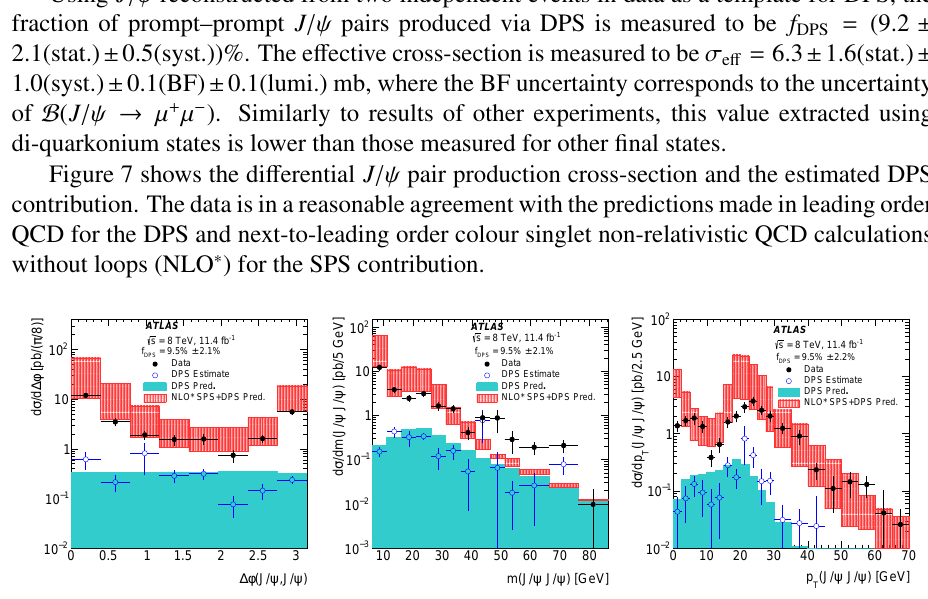
Figure 7. The DPS and the total di ff erential J /ψ pair production cross-section as a function of (left) the azimuthal angle between the two J /ψ mesons, (middle) their invariant mass, and (right) the pair p T . Overlaid are the predictions from leading order DPS and NLO ∗ SPS contributions. Figures are taken from Ref.